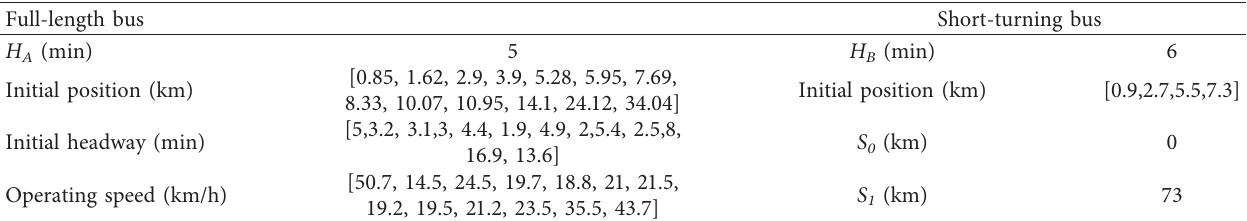
Table 2: The bus information has been departed at the initial time of the simulation of the full-length bus and the short-turning bus.